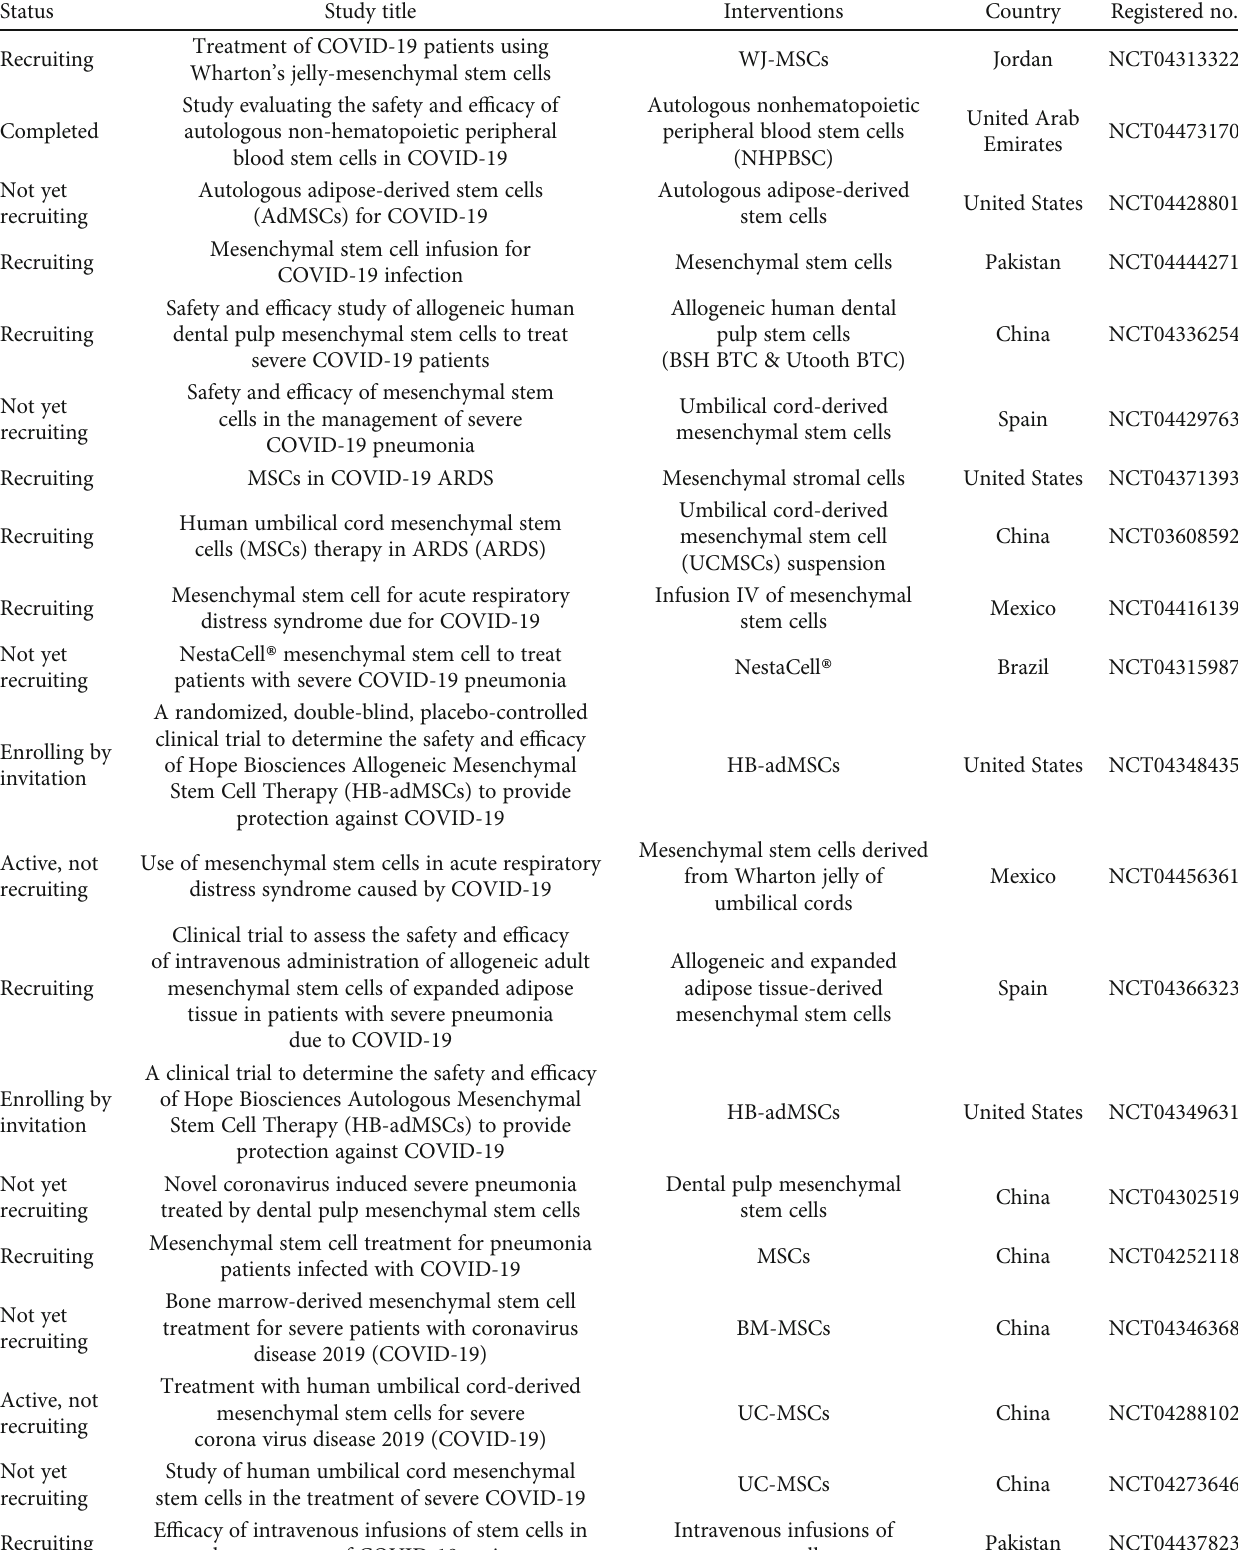
Table 1: The available clinical trials (https://clinicaltrials.gov/) using MSCs and/or MSCs-Exo to treat COVID-19 patients (last accessed on July 21,